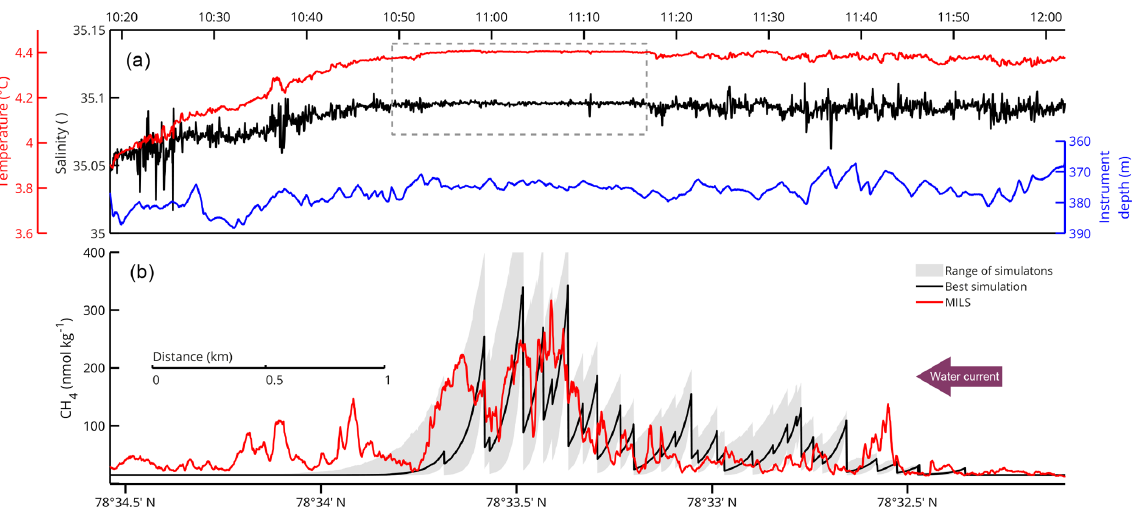
Figure 6. Water properties and comparison between modelled and measured dissolved CH 4 concentrations along line 3. (a) Shows temper- ature and salinity data together with the depth of the towed instruments. The dashed-line box highlights the area of intense mixing. In (b) , the red line shows the dissolved CH 4 measured by the MILS. The grey area indicates the range of CH 4 concentrations from the 2-D model simulations. The black line depicts output of the model simulation with the best match with the measured